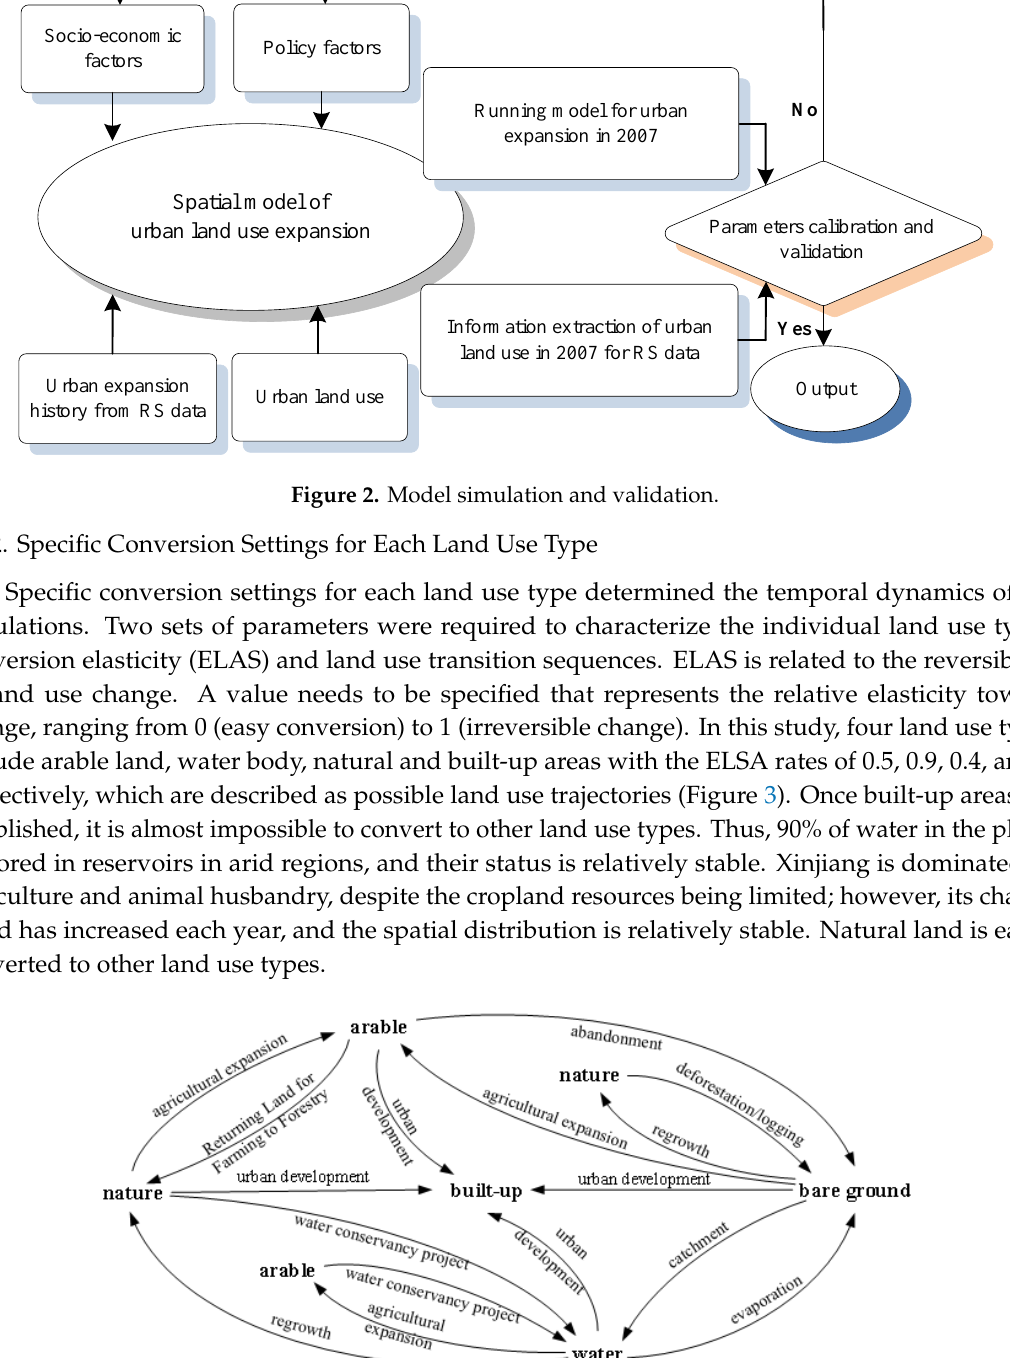
Figure 3. Possible land use trajectories. Nature in the middle right part and the left part of the figure has the same mean. The specific conversion settings for each land use type are specified in a conversion matrix that represents temporal characteristics. This matrix defines the other land use types to which the present